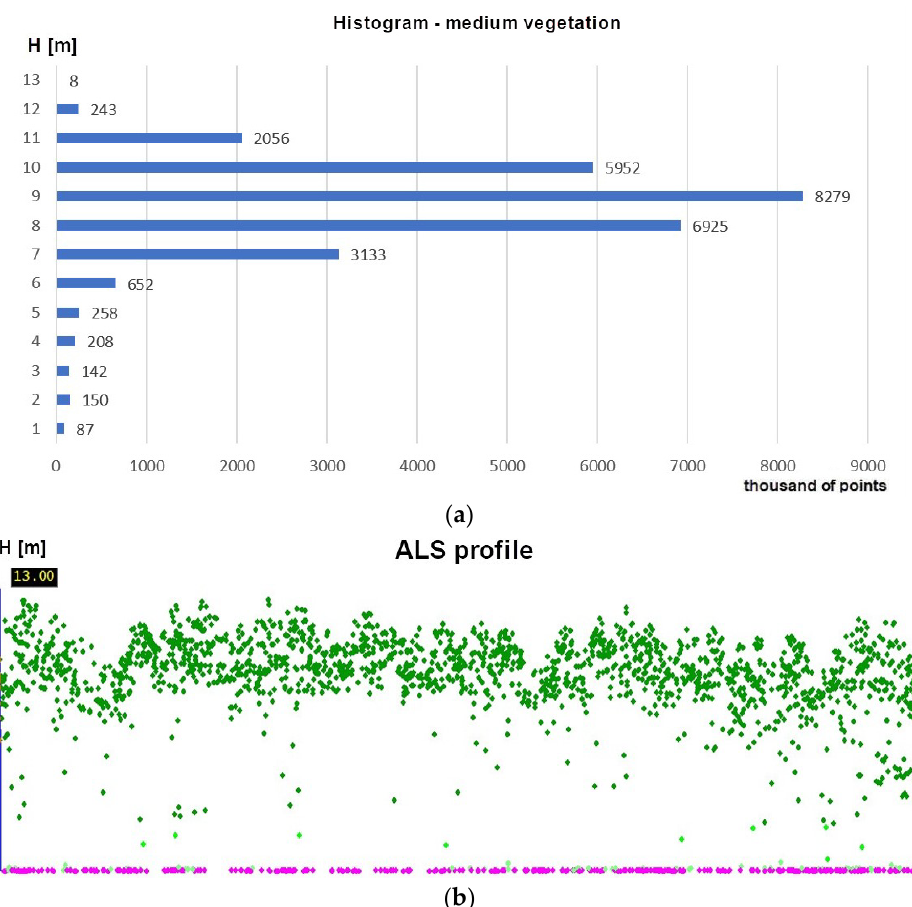
Figure 10. Medium vegetation: ( a ) histogram; ( b ) profile.